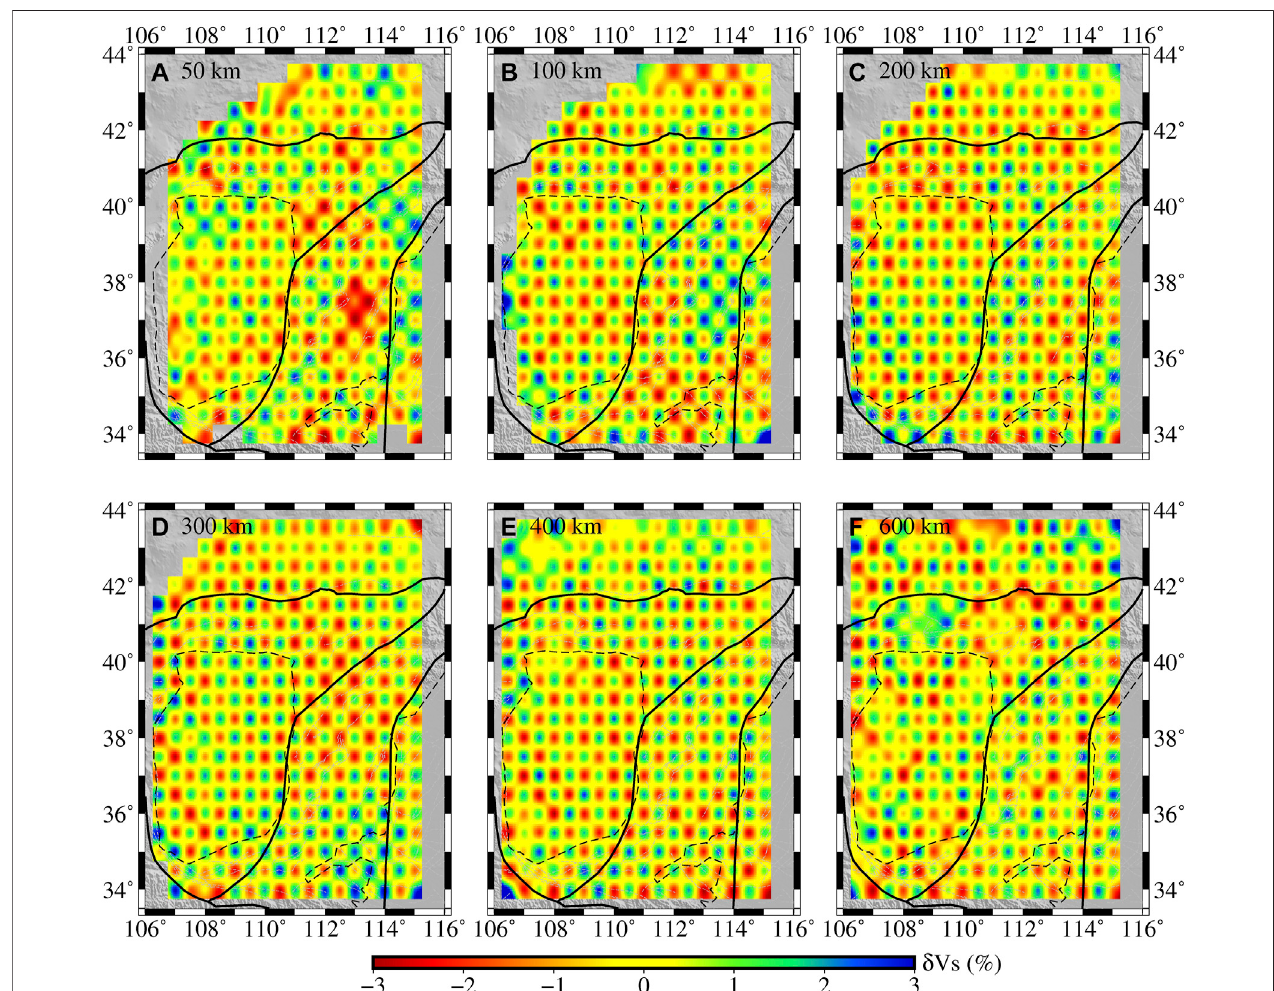
FIGURE 3 | The checkerboard resolution test for the S wave velocity inversion (A – F) The recovered results at depths of 50, 100, 200, 300, 400, and 600 km.